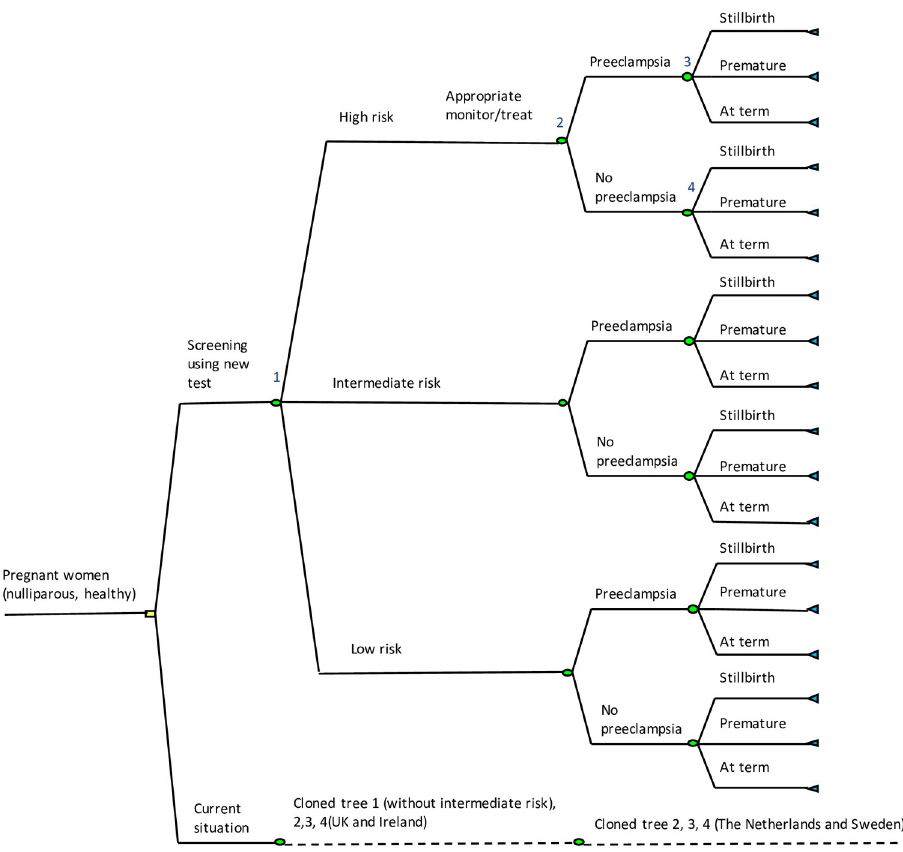
Fig 1. A decision tree comparing the new screening test strategy with the current screening test in UK, The Netherlands, Ireland, and Sweden. UK: United Kingdom.